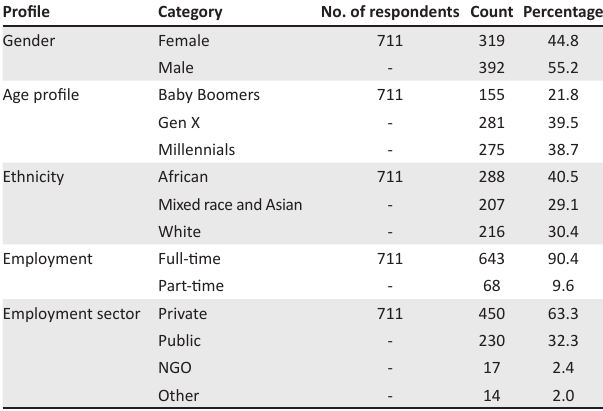
TABLE 1: Demographic profile of